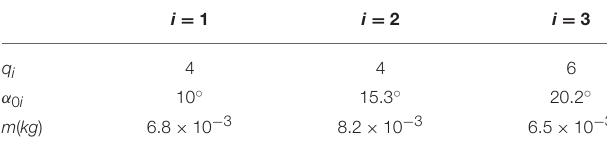
TABLE 3 | Optimal Complexities ( q i ), angles( α 0 i ), and masses( m i ) of ith